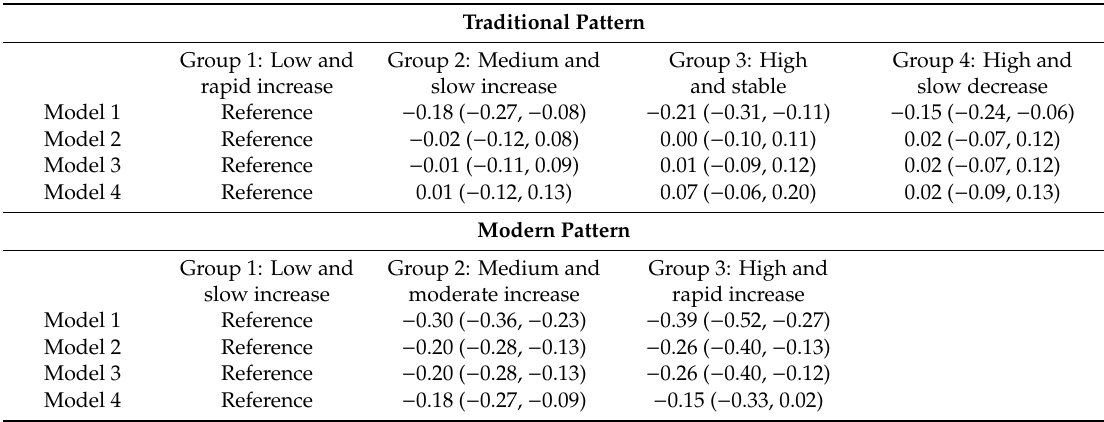
Table 3. Association between trajectories (between 1991 and 2009) of dietary patterns and sleep duration among adults participating in the China Health and Nutrition Survey in